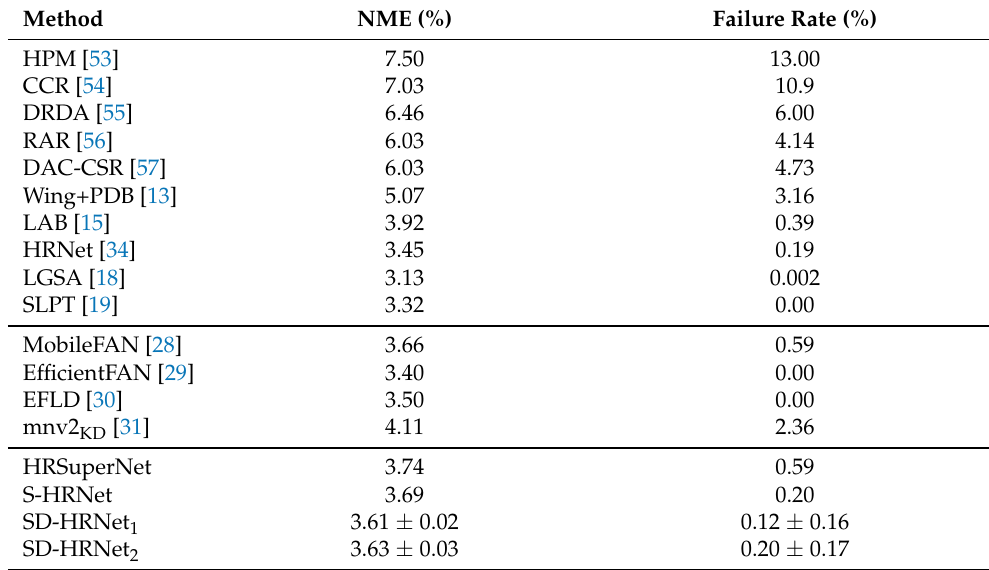
Table 4. Comparison of NME (%) and failure rate (%) for a maximum NME of 10% on the COFW test set.